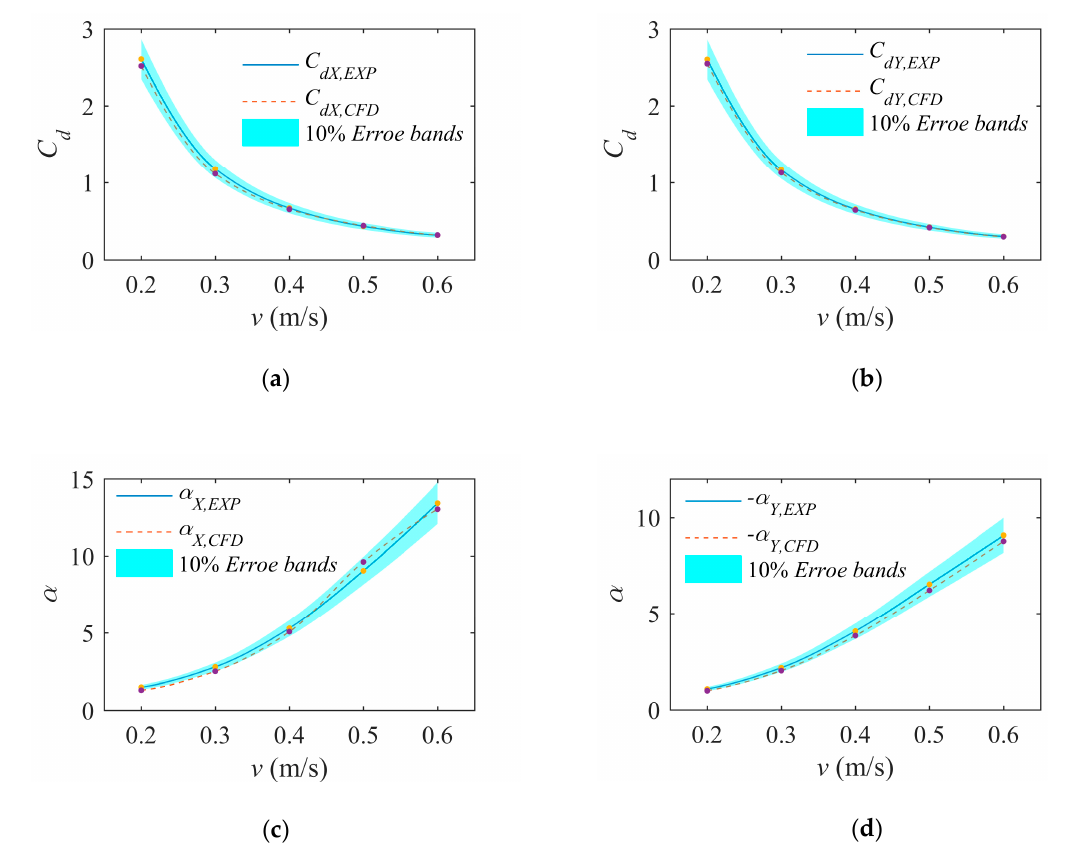
Figure 10. Drag coe ffi cient and o ff set angle variations with velocity in experiments and simulations: Figure 10. Drag coefficient and offset angle variations with velocity in experiments and simulations: ( a ) The variation of drag coe ffi cient with towing speed in X-direction towing, ( b ) The variation of drag ( a ) The variation of drag coefficient with towing speed in X-direction towing, ( b ) The variation of coe ffi cient with towing speed in Y-direction towing, ( c ) The variation of o ff set angle with towing speed drag coefficient with towing speed in Y-direction towing, ( c ) The variation of offset angle with in X-direction towing, ( d ) The variation of o ff set angle with towing speed in Y-direction towing. towing speed in X-direction towing, ( d ) The variation of offset angle with towing speed in Y-direction towing.